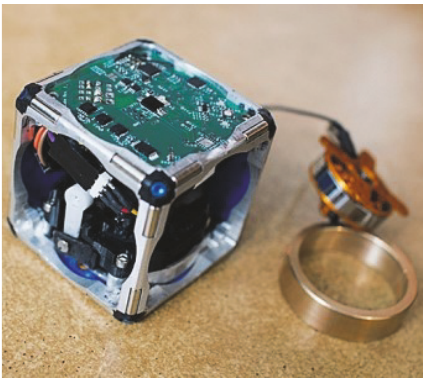
Figure 3: M-block MSRR (picture courtesy of M. Scott Brauer, source: http://news.mit.edu/2013/simple-scheme-for-self-assem-